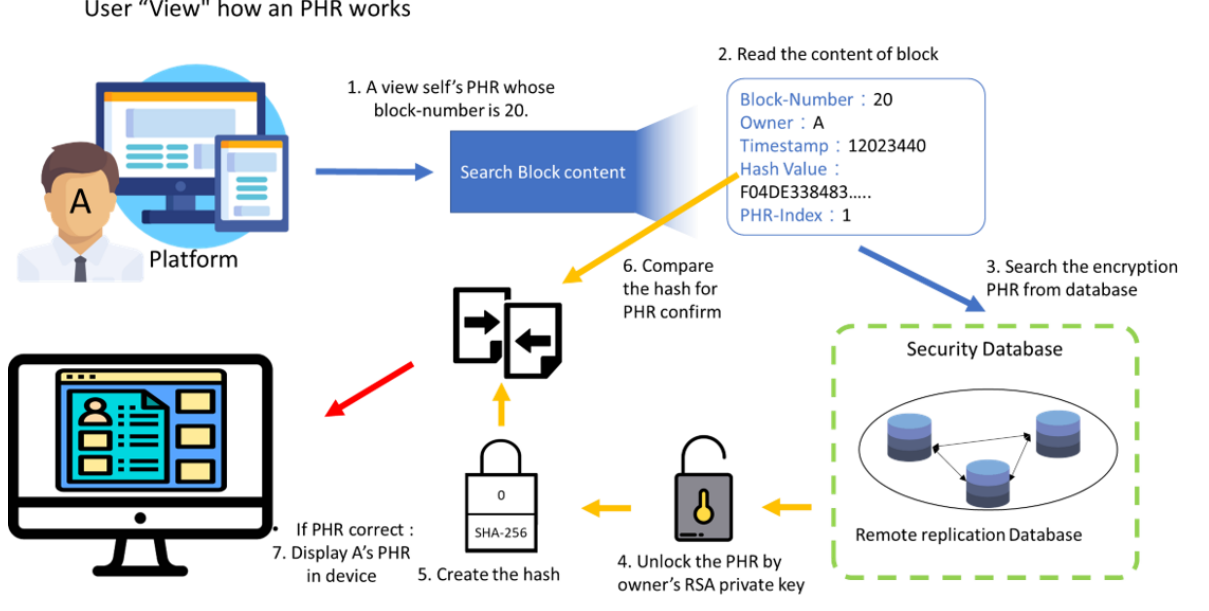
Figure 7. Workflow of a user viewing their own personal health record. PHR: personal health record; RSA: